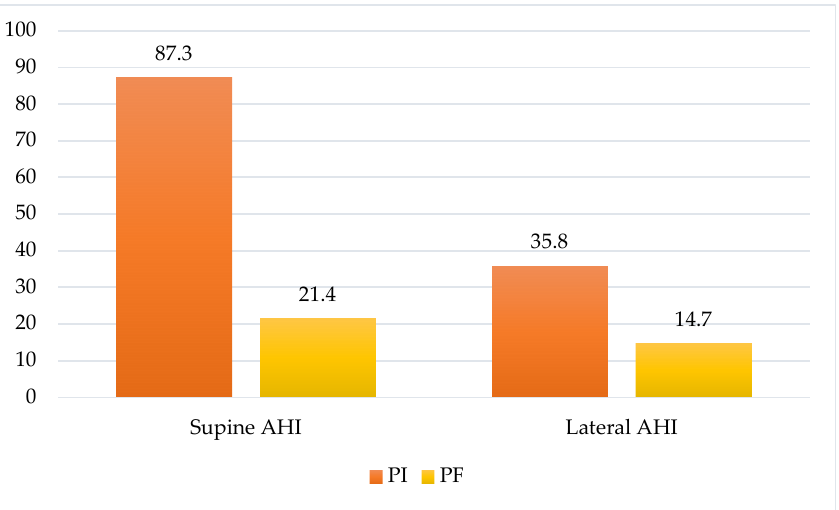
Figure 2. Apnea/hypopnea index (AHI) before (PI) and after (PF) treatment with the mandibular advancement device (MAD). There was a significant decrease in the evaluated values (supine position and lateral position AHI). The supine position AHI was 87.3/h before treatment (PI) and 21.4/h after treatment (PF). In the lateral position AHI, a value of 35.8/h was measured in PI, which decreased to 14.7/h in PF.